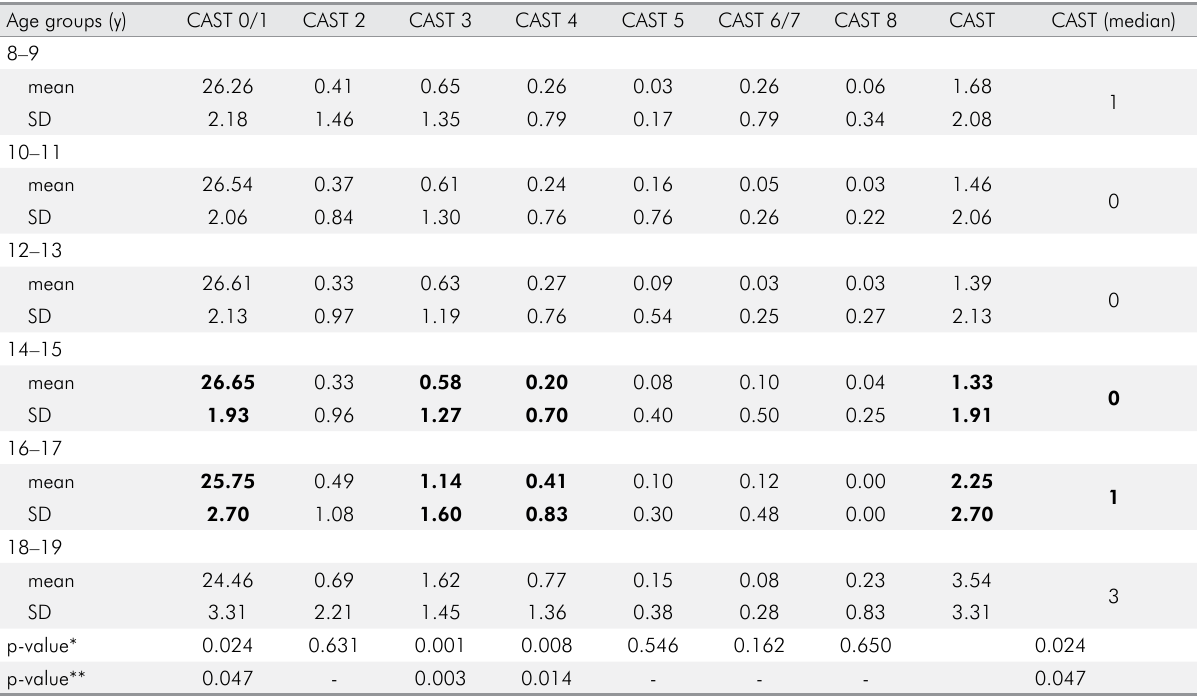
Table 3. CAST and CAST components values by age group of schoolchildren and adolescents. Age groups